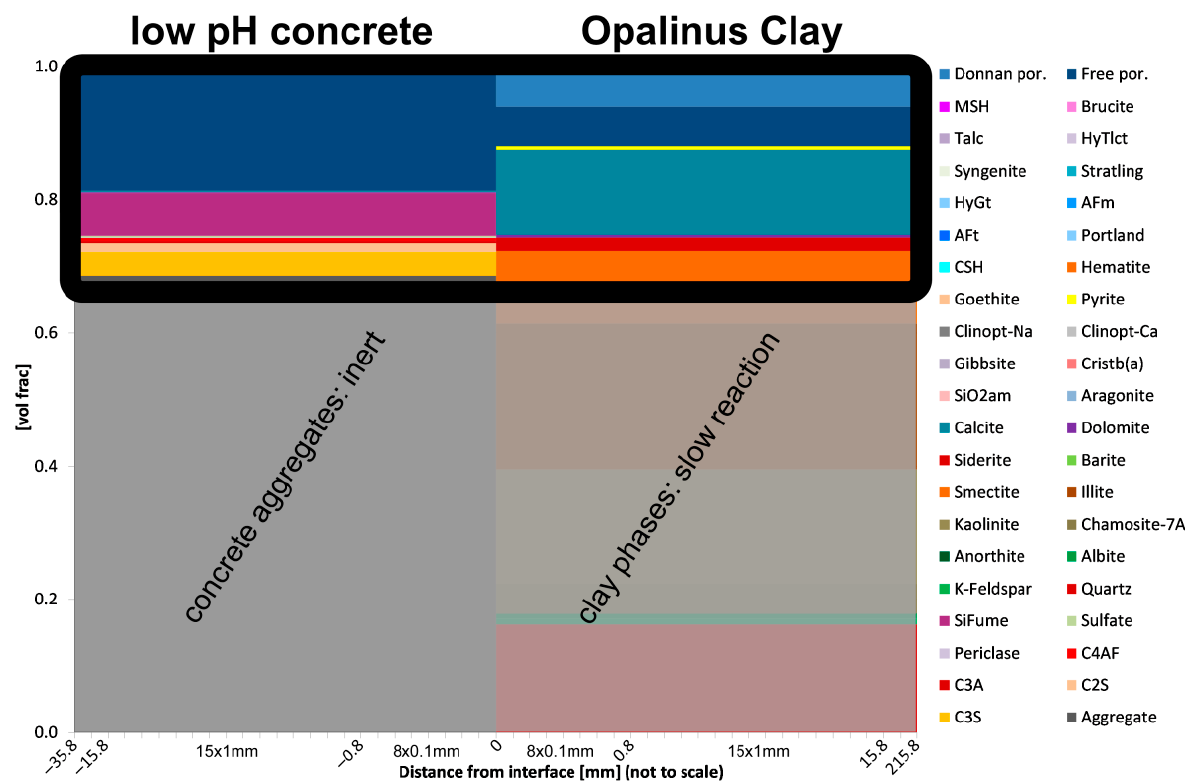
Figure 1. Phase volume fractions of initial condition of the concrete—OPA interface. The legend shows all phases considered in the model (por.: porosity; HyTlct: hydrotalcite; Stratling: strätlingite; HyGt: hydrogarnet; AFm: monosulphate; AFt: ettringite; Portland: portlandite; Clinopt: clinoptilolyte; Crist (a): alpha-cristobalite; SiO2am: amorphous silica; SiFume: silica fume; Sulfate: sum of gypsum, hemihydrate, anhydrite; C4AF: ferrite; C3A: aluminate; C2S: belite; C3S: alite). Only reactive phases ondergoing visible volume changes are shown in subsequent figures (top 30 vol%, black frame). The entire domain was discretised into 16 × 100 µ m-cells close to the interface, 30 × 1 mm-cells further away, and two large cells at the outer concrete and OPA boundaries.